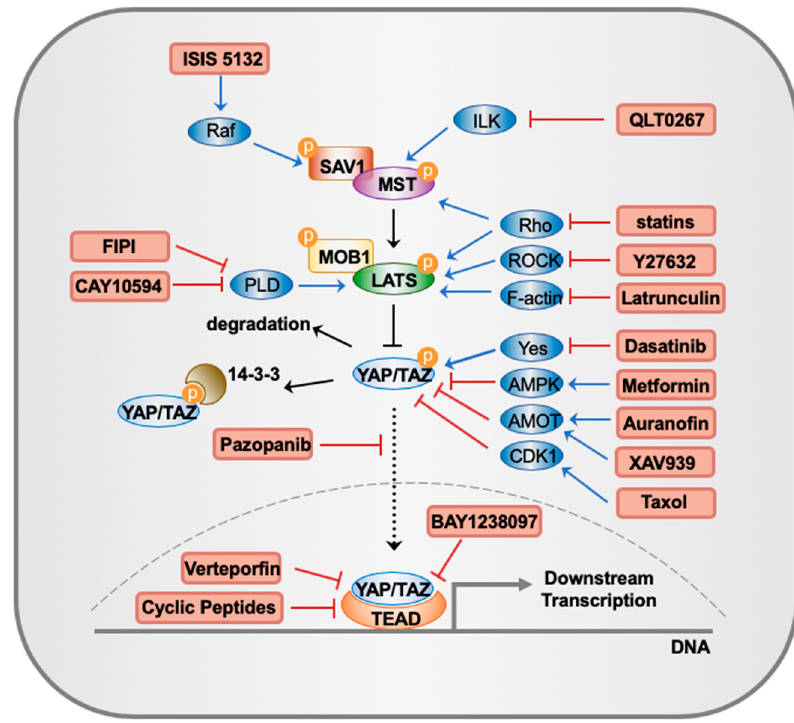
Figure 1. Main components of the Hippo pathway and the current Hippo-targeted inhibitors discussed in this review. In mammals, the canonical Hippo pathway consists of four core components that function through phosphorylation: MST, SAV1, LATS, MOB1. Activated LATS phosphorylates YAP/TAZ, preventing them from entering the nucleus by anchoring them to 14-3-3 protein and/or promoting their degradation in the cytoplasm. This interrupts their interactions with the transcription factor TEAD family proteins, which subsequently inhibits cell proliferation and oncogenic transformation and induces apoptosis. Besides, current Hippo-targeted inhibitors discussed in this review, as well as their targets and major mechanisms, are shown in the figure.